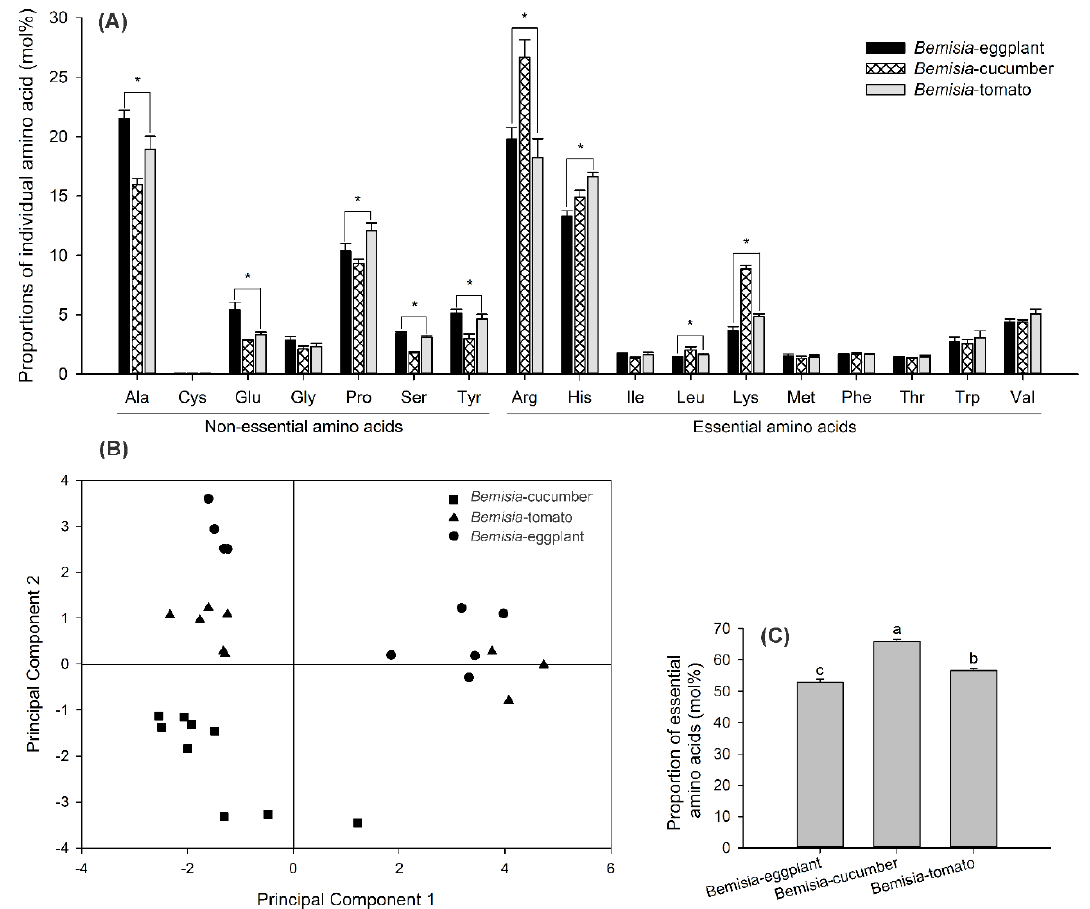
Figure 6. Proportions of individual amino acids (mean ± SE; mol%; A ), amino acid composition–profile analysis by PCA ( B ), and percentage of the entire EAAs in three whitefly populations (G0), termed Bemisia -eggplants, Bemisia -cucumbers, and Bemisia -tomatoes (mol%) ( C ). Asterisks or different letters above the error bars indicate significant differences in individual amino-acid levels or percentage of the entire EAAs among the whitefly populations ( p < 0.05, Tukey’s HSD test).